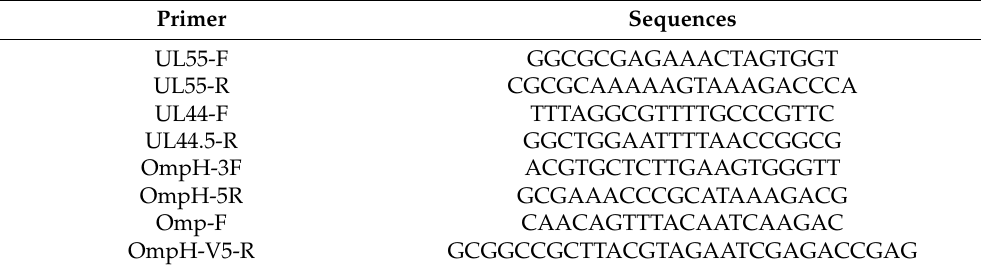
Table 3. Primers used for junction PCR and OmpH *-V5 gene inserted